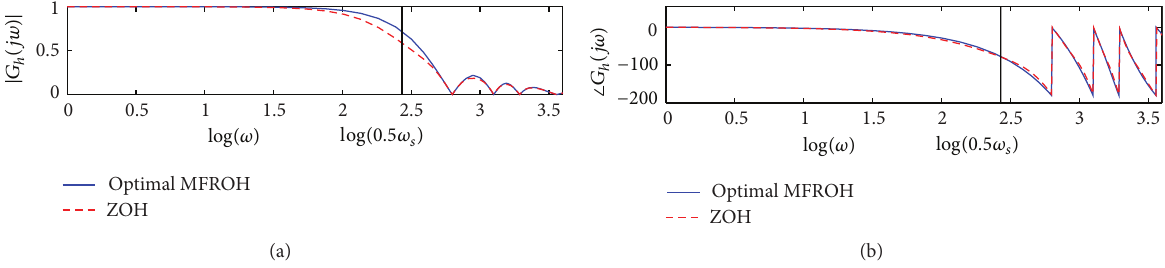
Figure 7: Amplitude and phase of the frequency response of ZOH and MFROH with optimal 𝛽 and Δ